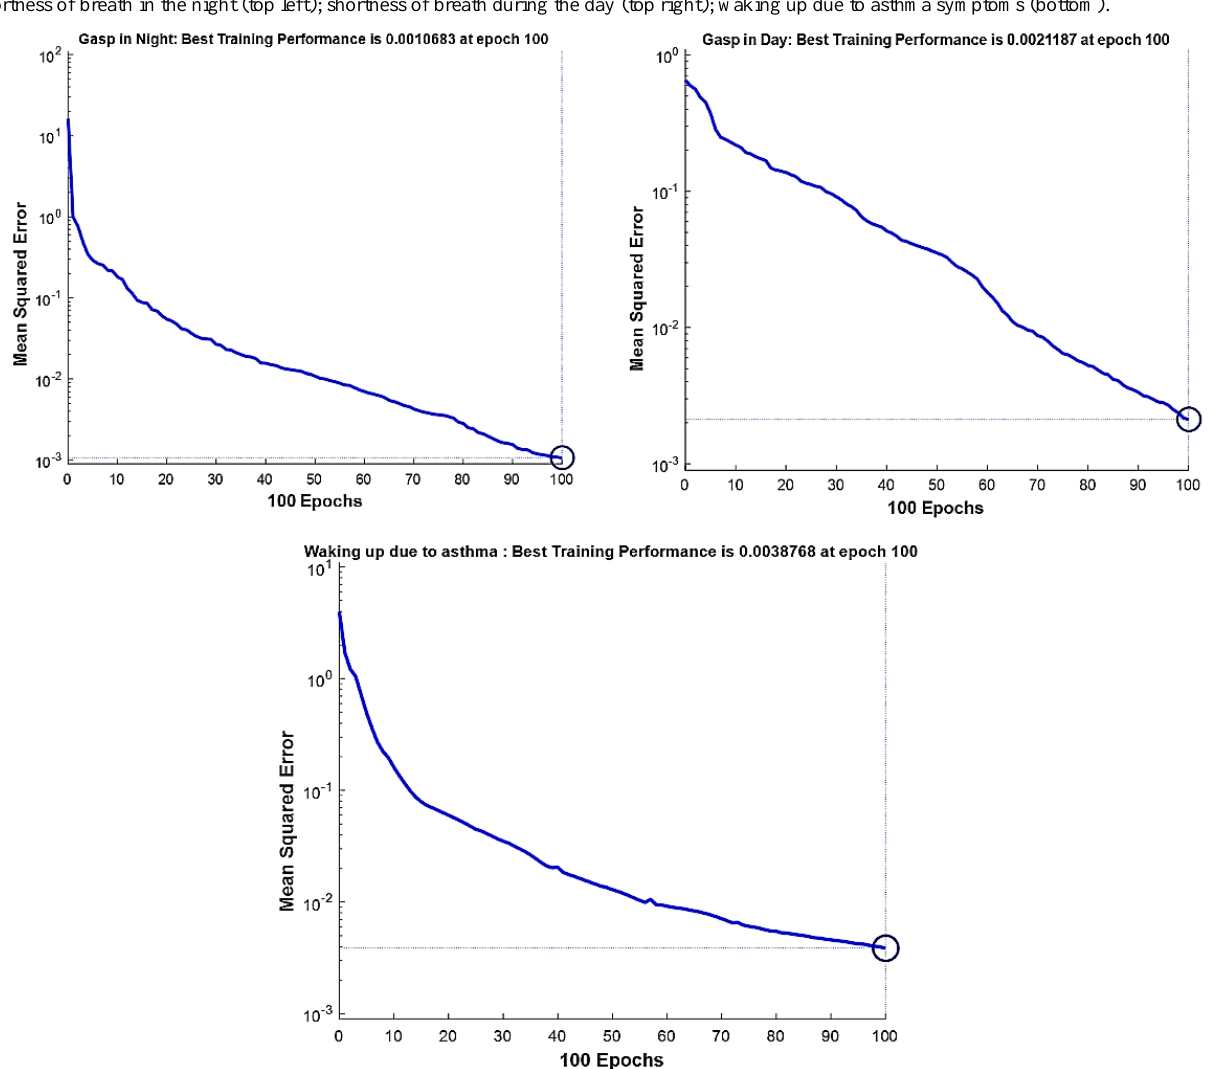
Figure 6. Training performance of the genetic algorithm–modified neural network for C sativus L supplement effects on the asthma clinical symptoms: shortness of breath in the night (top left); shortness of breath during the day (top right); waking up due to asthma symptoms (bottom).